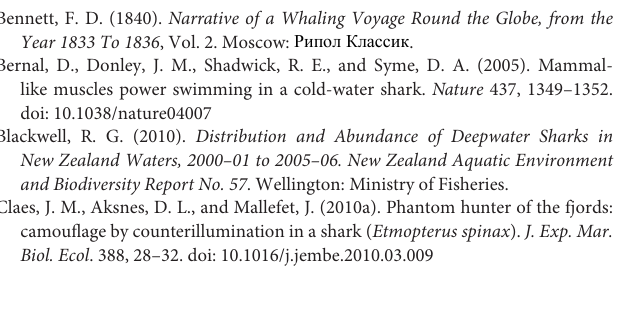
Supplementary Table 4 | MT dose response, statistical analyses. Kruskal-Wallis ANOVA and pairwise Wilcoxon test results for the MT dose response of the three studied sharks. Gray-shaded cases represent not significant differences. Supplementary Table 5 | α -MSH and ACTH effects, statistical analyses. ANOVA and Tukey’s test results for the decrease of light triggered by α -MSH and ACTH treatments (except for E. granulosus non-parametric test). Gray-shaded cases represent not significant